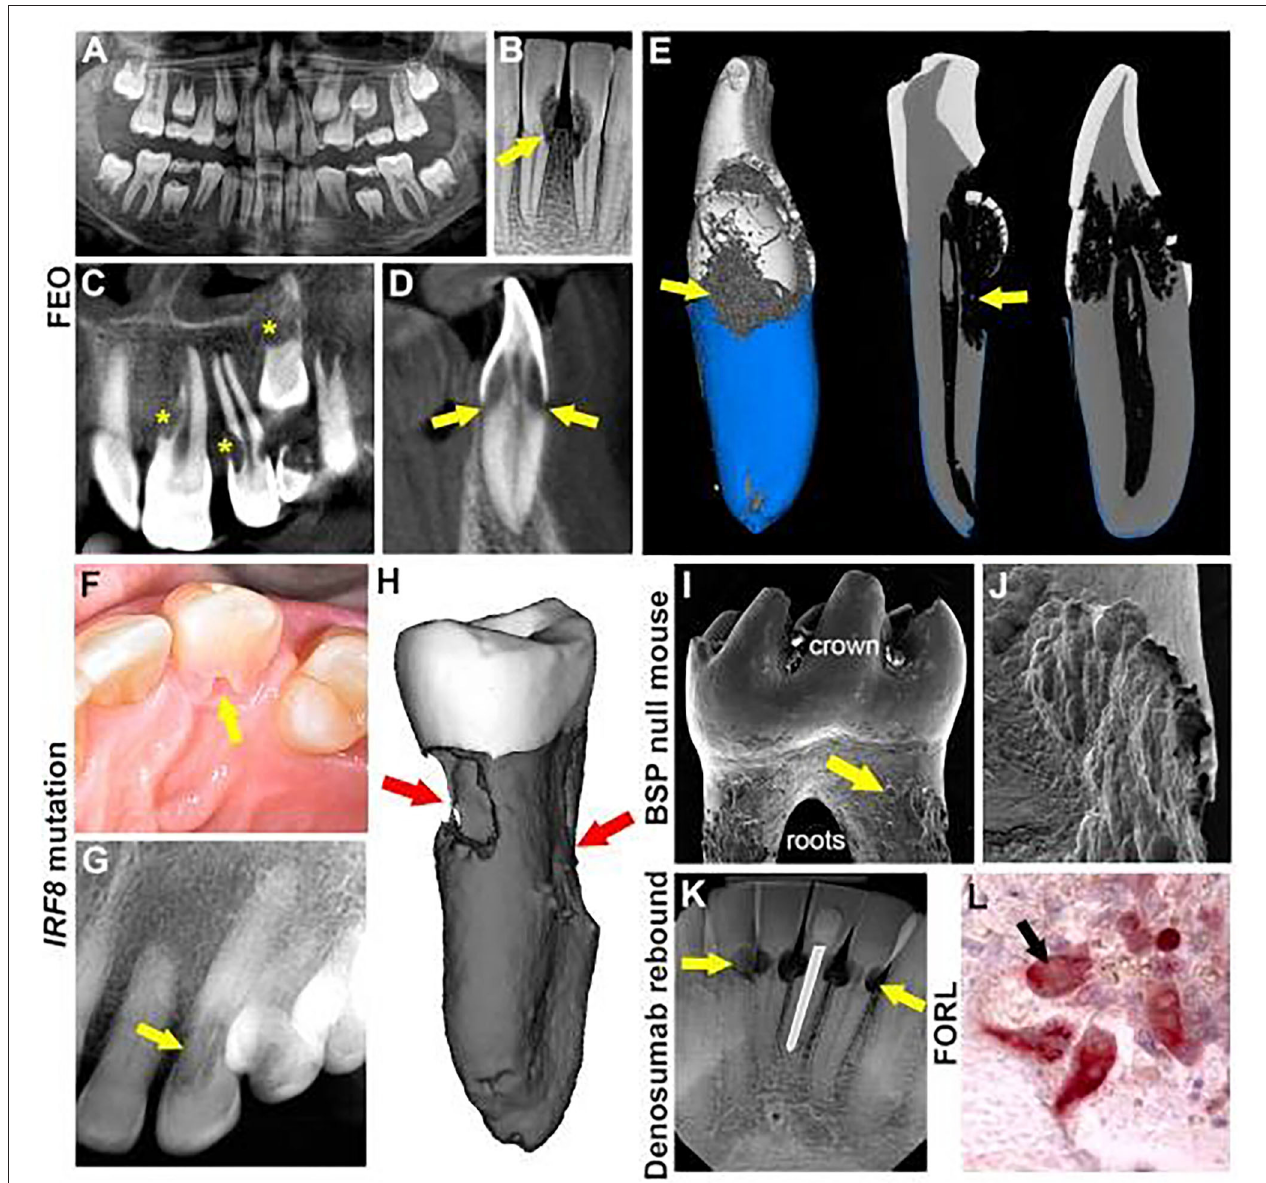
FIGURE 1 | Multiple etiologies of MICRR. (A) Panoramic radiograph of 8-year-old female with familial expansive osteolysis (FEO) associated with TNFRSF11A variant showing cervical root resorption of permanent maxillary and mandibular incisors (yellow arrows). (B) Periapical radiograph of the same patient with FEO, at 9-years-old, showing extent of external resorption (yellow arrows). (C,D) Cone beam computed tomography (CBCT) of the same patient at 9-years-old showing extensive resorption of permanent central and lateral incisors (yellow stars) and unerupted canine (yellow star and yellow arrows). (E) 3D micro-computed tomography (micro-CT) reconstruction of incisor of the same FEO patient at age 9, noting defective cementum formation and root resorption. (F) Intraoral photograph of an advanced resorption lesion (yellow arrow) on the palatal aspect of tooth from affected individual with an inherited IRF8 variant. (G) Radiograph of the lesion (yellow arrow) shown in (F) . (H) Micro-CT reconstruction of an extracted tooth exhibiting extensive cervical resorption (red arrows). (I) Scanning electron microscopy (8) image of BSP null mouse molar showing abundant pitting (yellow arrows) at cervical root surfaces. (J) Higher magnification SEM of the tooth in panel I showing details of cervical root resorption in BSP null mouse molar. (K) Periapical radiograph of lower anterior teeth in 69-year-old patient, after discontinuation of denosumab, showing multiple areas of cervical root resorption (yellow areas). (L) Tartrate-resistant acid phosphatase (TRAP) stain of histology section showing multinucleated odontoclasts (red cells, black arrow) on root surfaces of a cat with feline odontoclastic resorption lesions (FORL). (A–D) reproduced with permission from Macaraeg et al. (9). (F,G) reproduced with permission from Neely et al. (10). (I) reproduced with permission from Foster et al. (11). (K) Copyright © 2020 American Academy of Pediatric Dentistry and reproduced with their permission